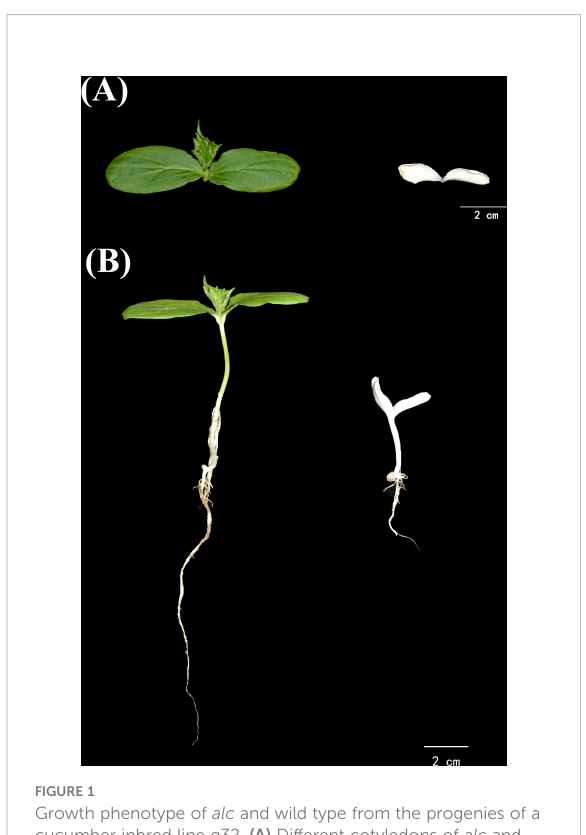
FIGURE 1 Growth phenotype of alc and wild type from the progenies of a cucumber inbred line g32. (A) Different cotyledons of alc and wild type seedlings. (B) Morphological difference between alc and wild type